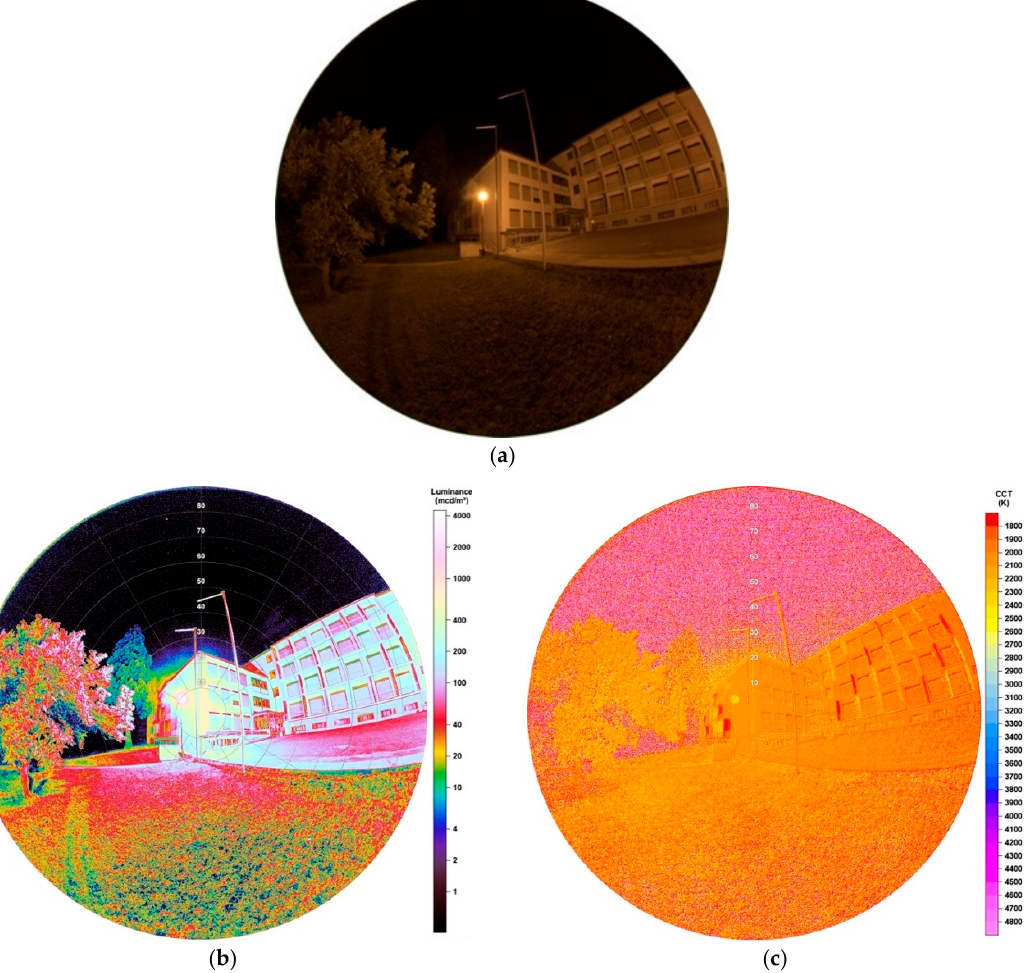
Figure 6. ( a ) Image of ball light during night-time taken with fisheye lens for detailed analysis (date: 29.07.2019, 23:15 h; exposure time: 0.4 s); ( b ) Luminance matrix of image (a) as displayed by SQC; ( c ) CCT matrix of image (a) as displayed by SQC.